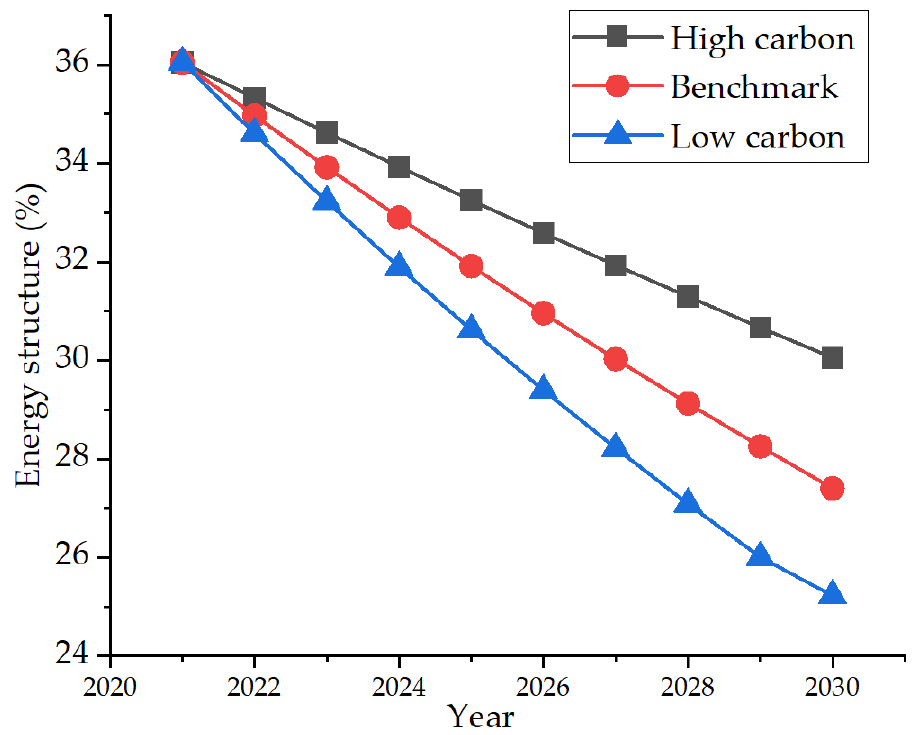
Figure 11. Three energy structure development scenarios .